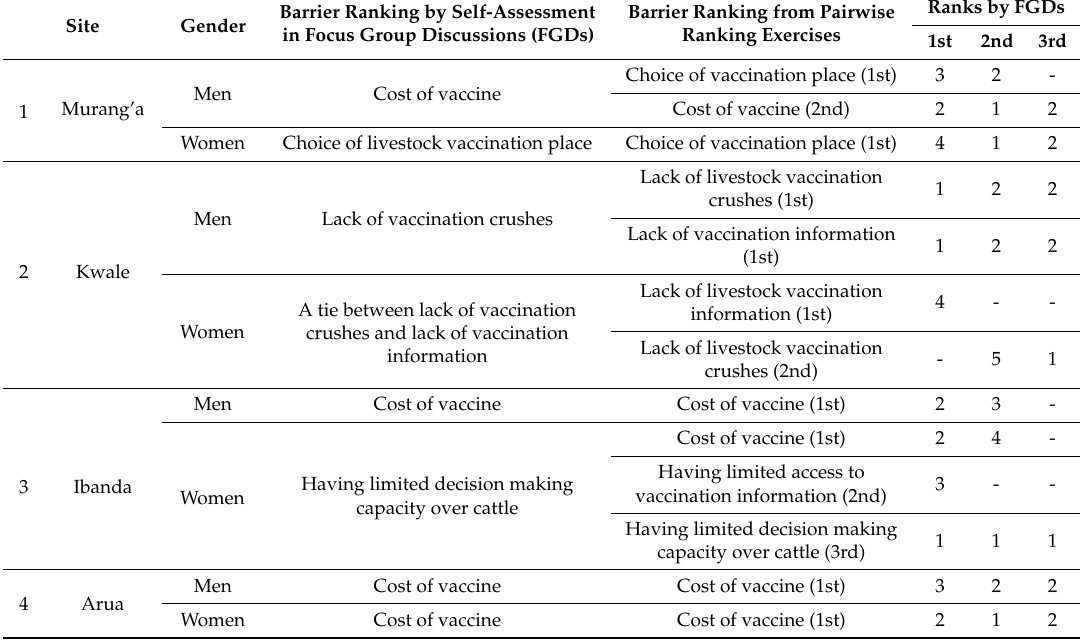
Table 3. A comparison between self-assessment of barriers to livestock vaccine uptake and pairwise ranking exercise